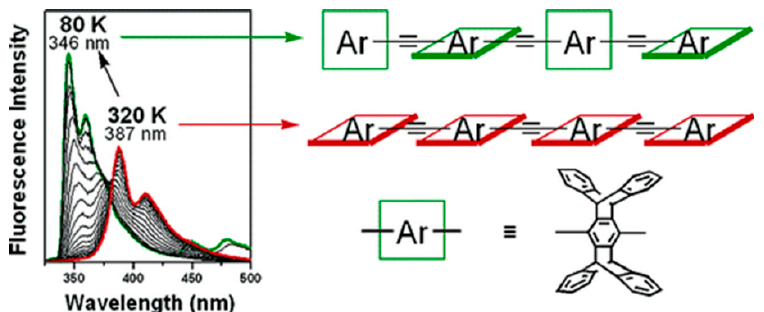
Figure 3. The change of conformation caused by temperature difference influence the fluorescence properties. Temperature dependence of fluorescence spectra ( ʎ ex = 303 nm) of tetramer in methylotetrafuran at 20- and 10-K intervals, respectively, between 80 and 320 K. Reprinted with permission from [67] . Copyright 2006 American Chemical Society.